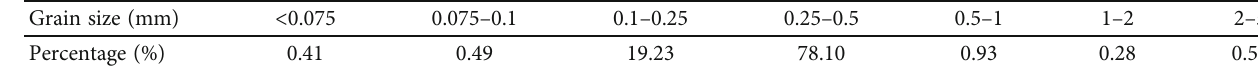
Table 1: Model tests soil mass grain content percentage.